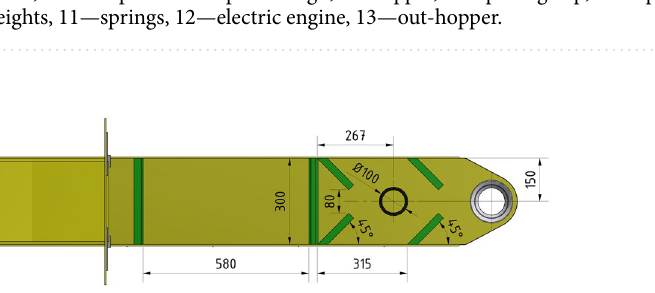
Figure 7. Dimensional drawing of the deployment of passive elements on the vibrating trough—view from